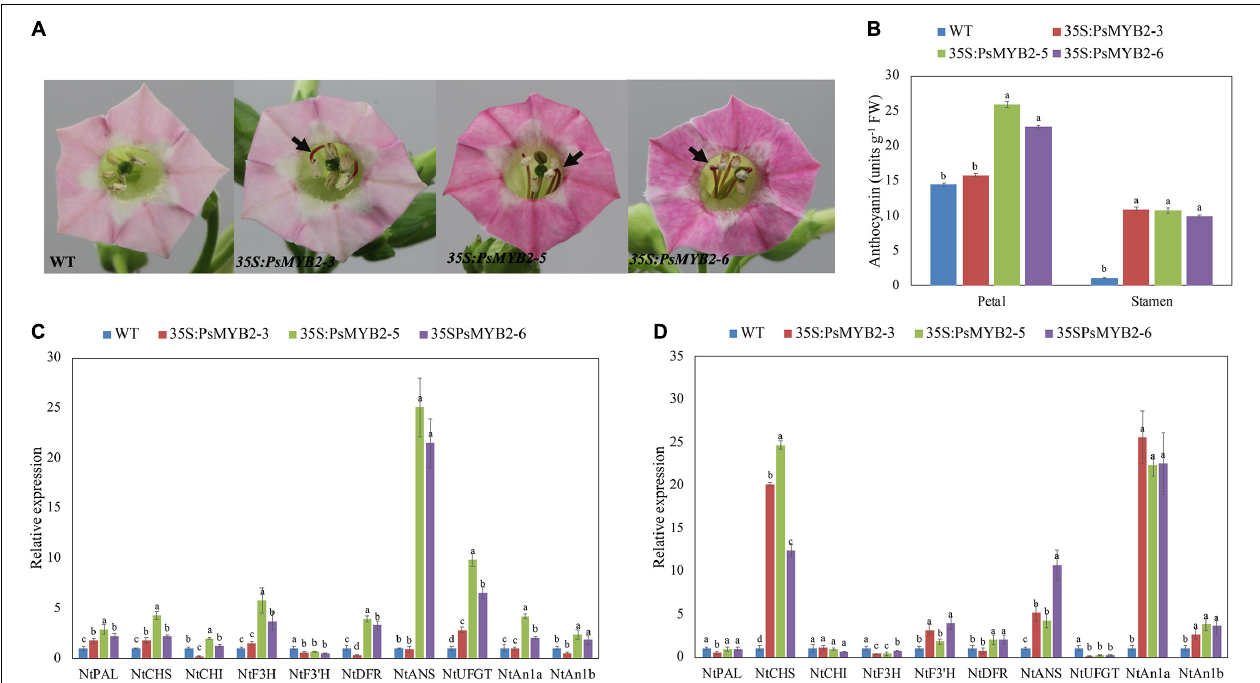
FIGURE 7 | Overexpression of PsMYB2 in tobacco. (A) Overexpression of PsMYB2 increased the anthocyanin accumulation in tobacco flowers. Flowers of transgenic tobacco showed increased pigmentation in petal and stamen, compared to wild-type flowers. (B) The TA content in the petal and stamen of the transgenic flowers was higher than that of the wild type. (C,D) Were the gene expression levels related to anthocyanin biosynthesis in the petal and stamen of tobacco flowers, respectively. Each value was expressed as the mean ± standard errors (SE) of triplicate replications. Different small letters indicated significant differences among PsMYB2 transgenic lines and wild-type plants according to Duncan’s multiple range test at p < 0.05. WT, wild-type plant; 35S:PsMYB2 (3, 5, and 6), plant overexpressing PsMYB2.